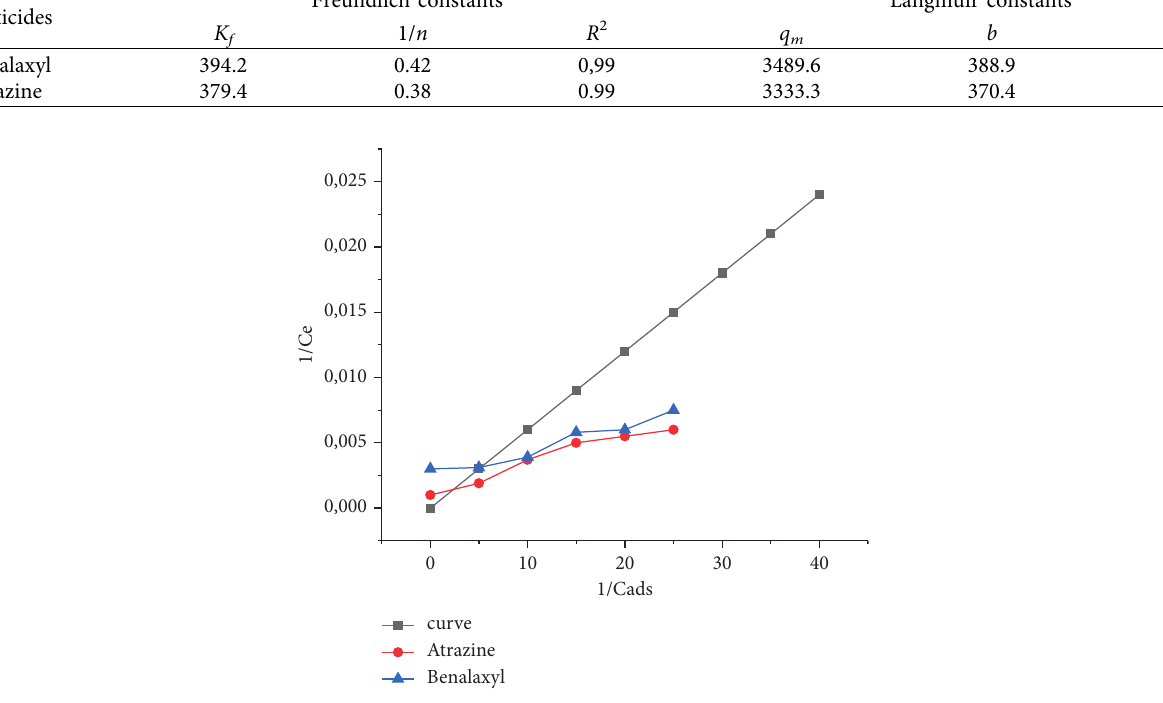
Figure 8: Langmuir adsorption isotherm for benalaxyl and atrazine in coal FAPP (Kosovo A). Table 6: Amount of benalaxyl and atrazine desorbed by coal FAPP (Kosovo A). Concentration ( µ g/ml) The amount